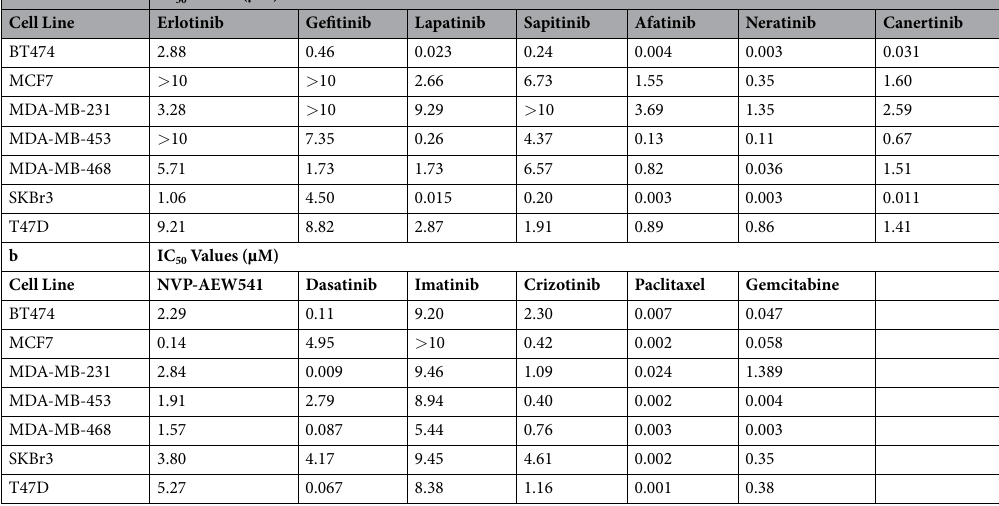
Table 2. IC50 values for cell lines treated with various agents. (a) HER-family targeting TKIs and (b) other TKIs and chemotherapeutic agents. Each value is the mean of triplicate